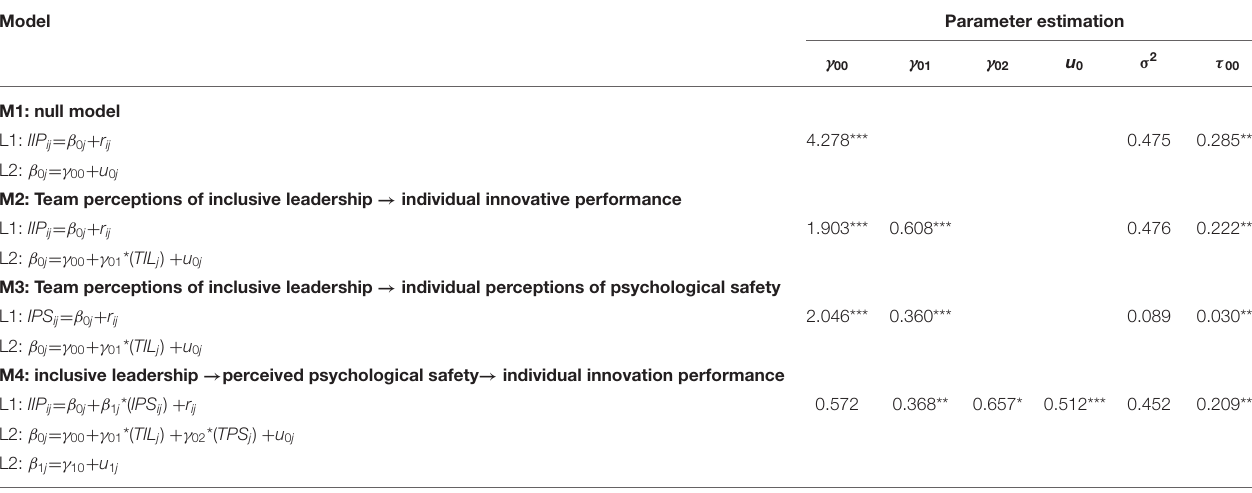
TABLE 7 | Results of hierarchical linear model.